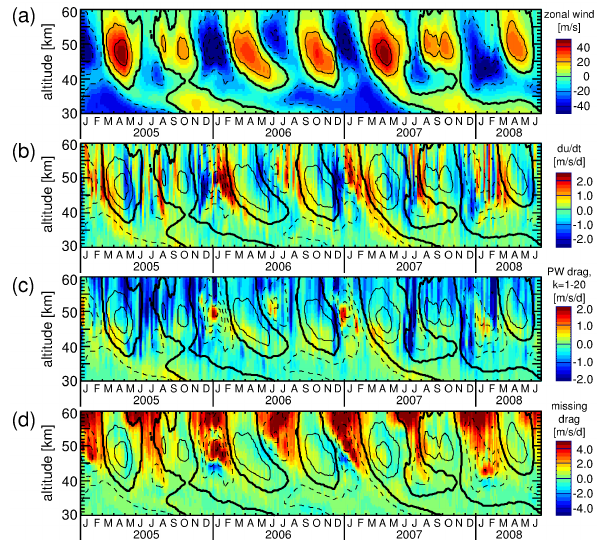
Figure 1. Altitude–time cross sections of the 10 ◦ S–10 ◦ N av- erage (a) ERA-Interim zonal wind in ms − 1 , and the following terms of the ERA-Interim tropical momentum budget in ms − 1 d − 1 : (b) zonal wind tendency ∂u/∂t , (c) planetary wave drag from EP flux divergence including zonal wave numbers 1–20, and (d) miss- ing drag that is attributed to gravity waves. Contour lines represent the zonal wind from (a) . The bold solid line is the zero wind line. Dashed (solid) lines indicate westward (eastward) wind. Contour interval is 20ms − 1